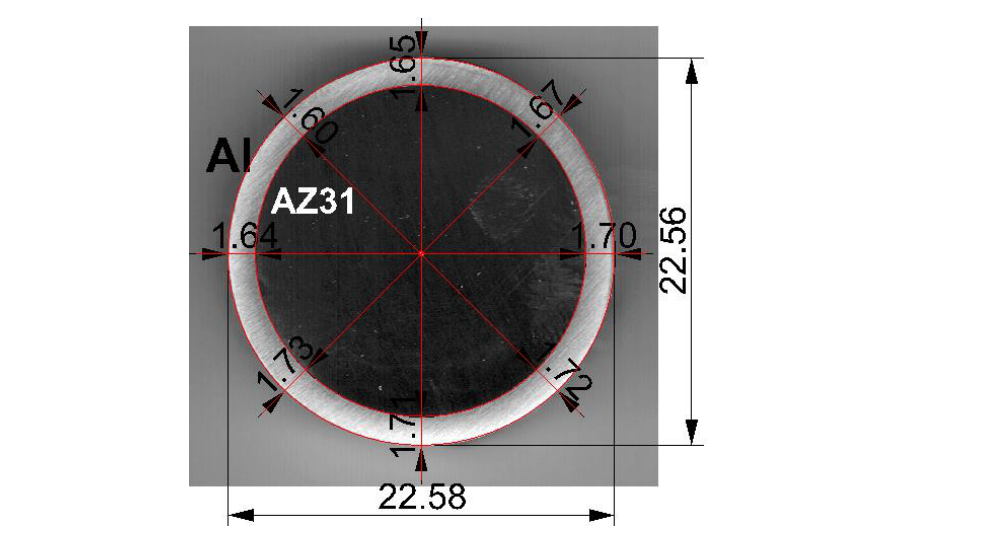
Table 2. Pattern of deformations used in the rolling process of Mg/Al bimetallic bars.